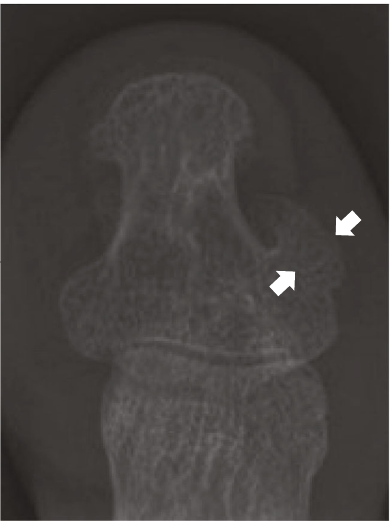
Figure 3: Measurement of the maximal width of the medial bone excrescence of the distal phalanx of the hallux Table 1: Patients ’ backgrounds and radiographic measurements in the osteotomy and arthrodesis groups.